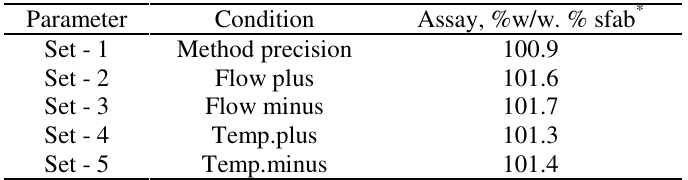
Table 4. Summary of results from robustness